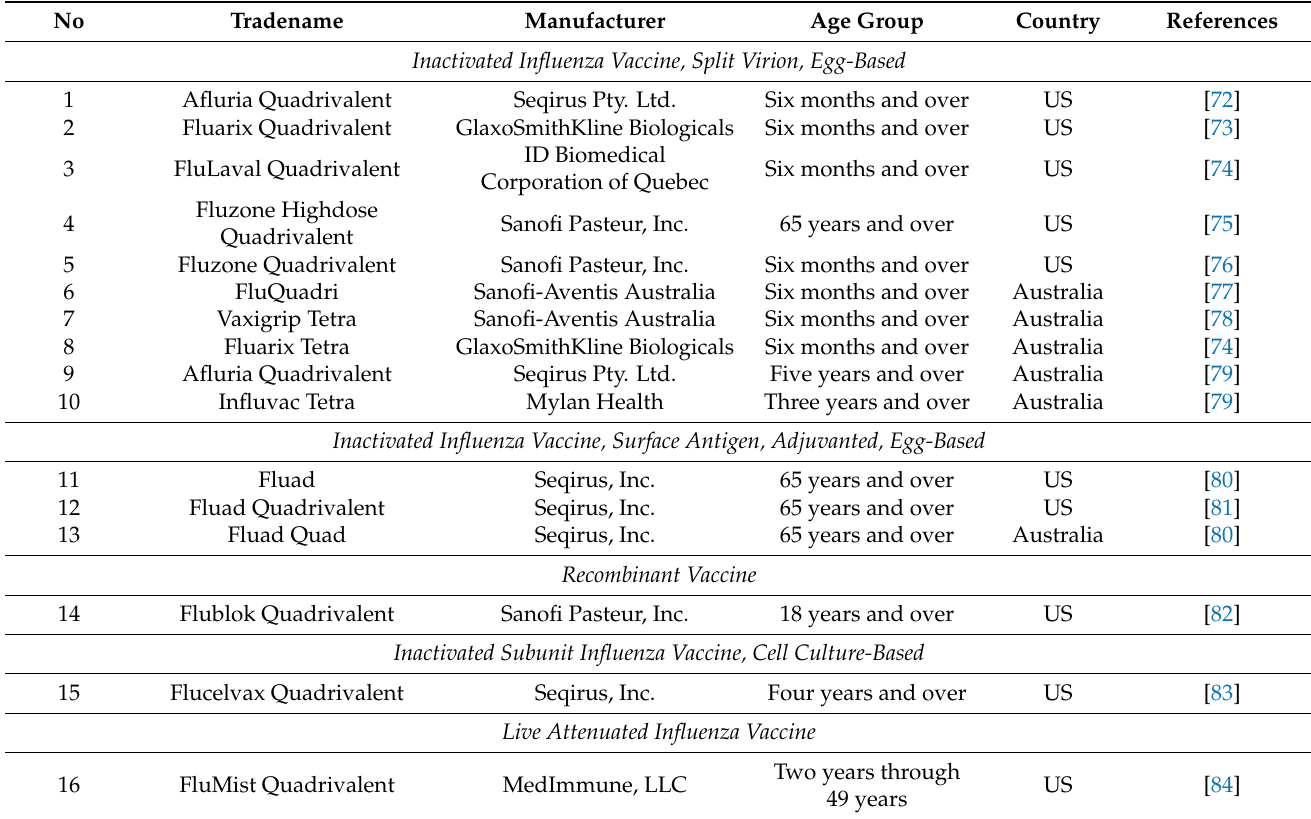
Table 1. Various licensed seasonal influenza vaccines available in the US (representing the northern hemisphere) and Australia (representing the southern